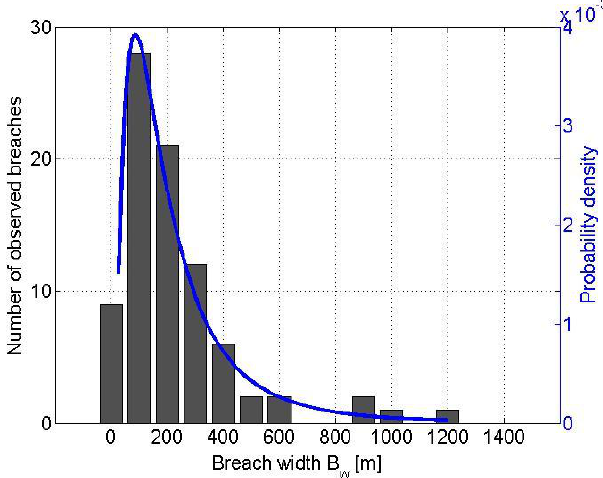
Fig. 4. Empirical frequency distribution of breach widths, B w , ob- served along the Po River in the period 1800–1951 (bars) and fitted probability density distribution (blue line; log-normal).